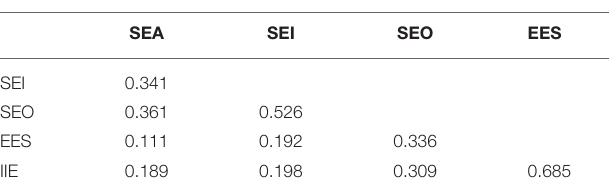
TABLE 10 | Correlation between